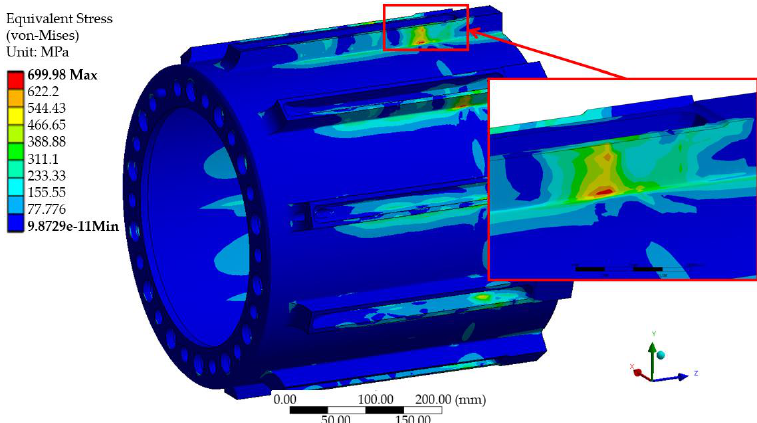
Figure 8. Von Misses stress distribution in the torque tube of the brake.